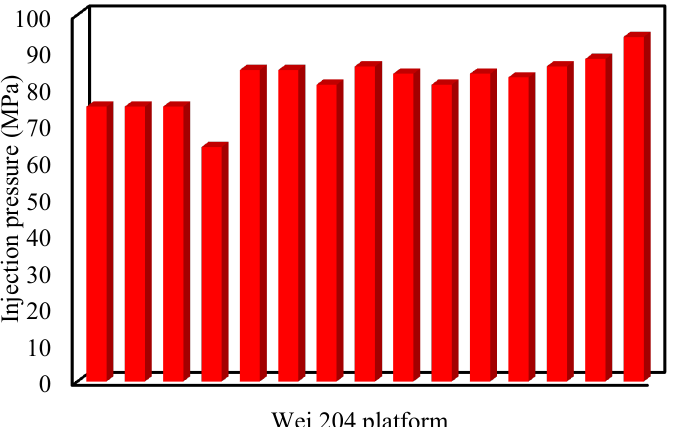
Figure 11. Fracturing injection pressure of 15 deformed casing wells in the Weiyuan 204 platform.